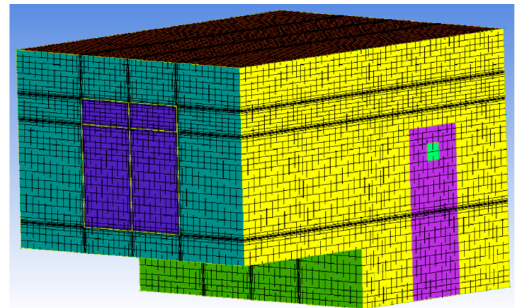
Figure 9. Structural meshing of room models.